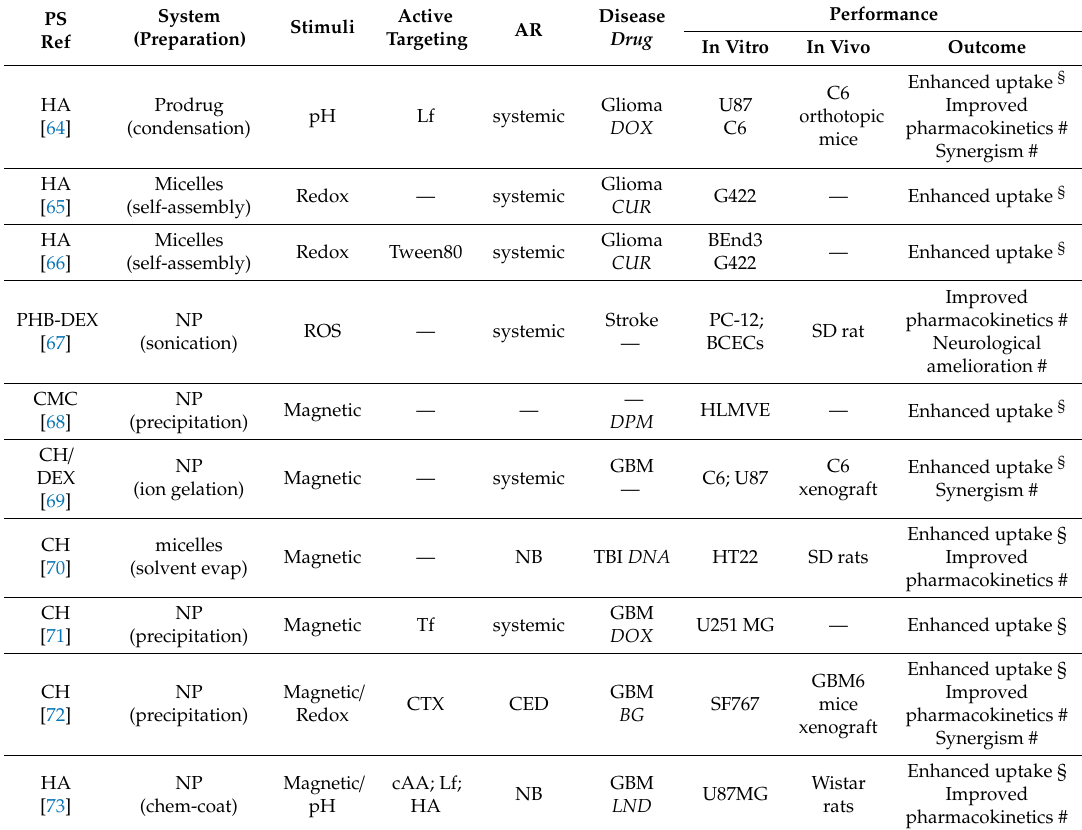
Table 2. Stimuli-responsive PSC in brain